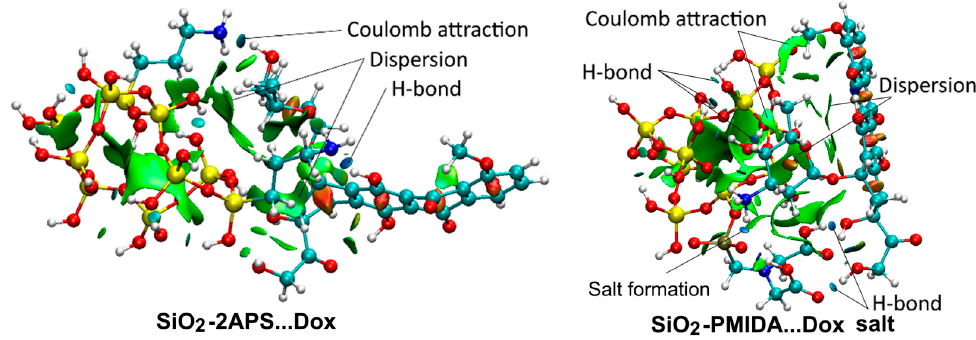
Figure 8. NCIplot images of noncovalent interactions in Dox complexes with a SiO 2 -2APS and SiO 2 -PMIDA-Dox salt 2 in water. Electron density iso -surfaces in the range of reduced electron density gradient ( s ) –0.07 < s < 0.07 at. units. Coloring in the BGR palette from blue (attraction) to red (repulsion).